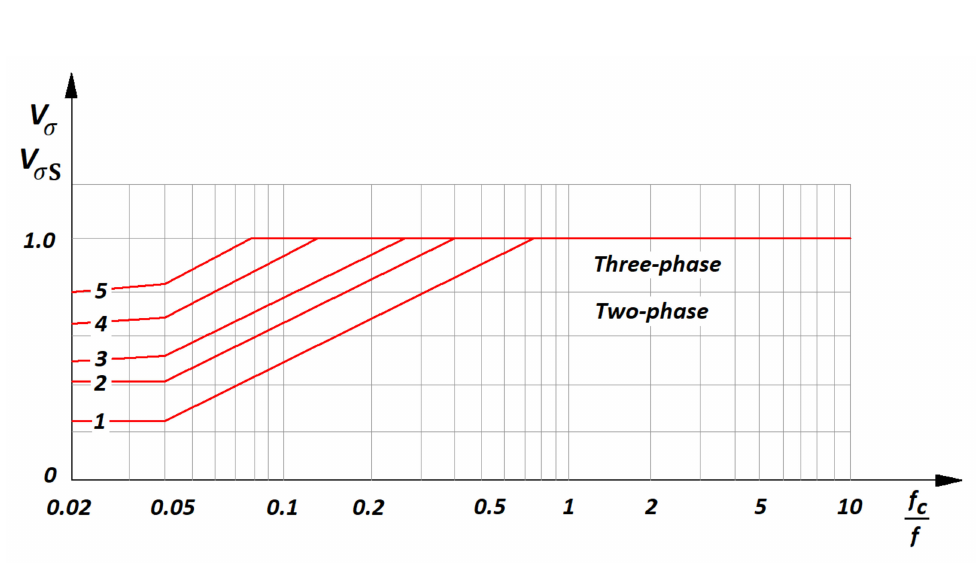
Figure 8. Graphs for determining the dynamic bending stress coe ffi